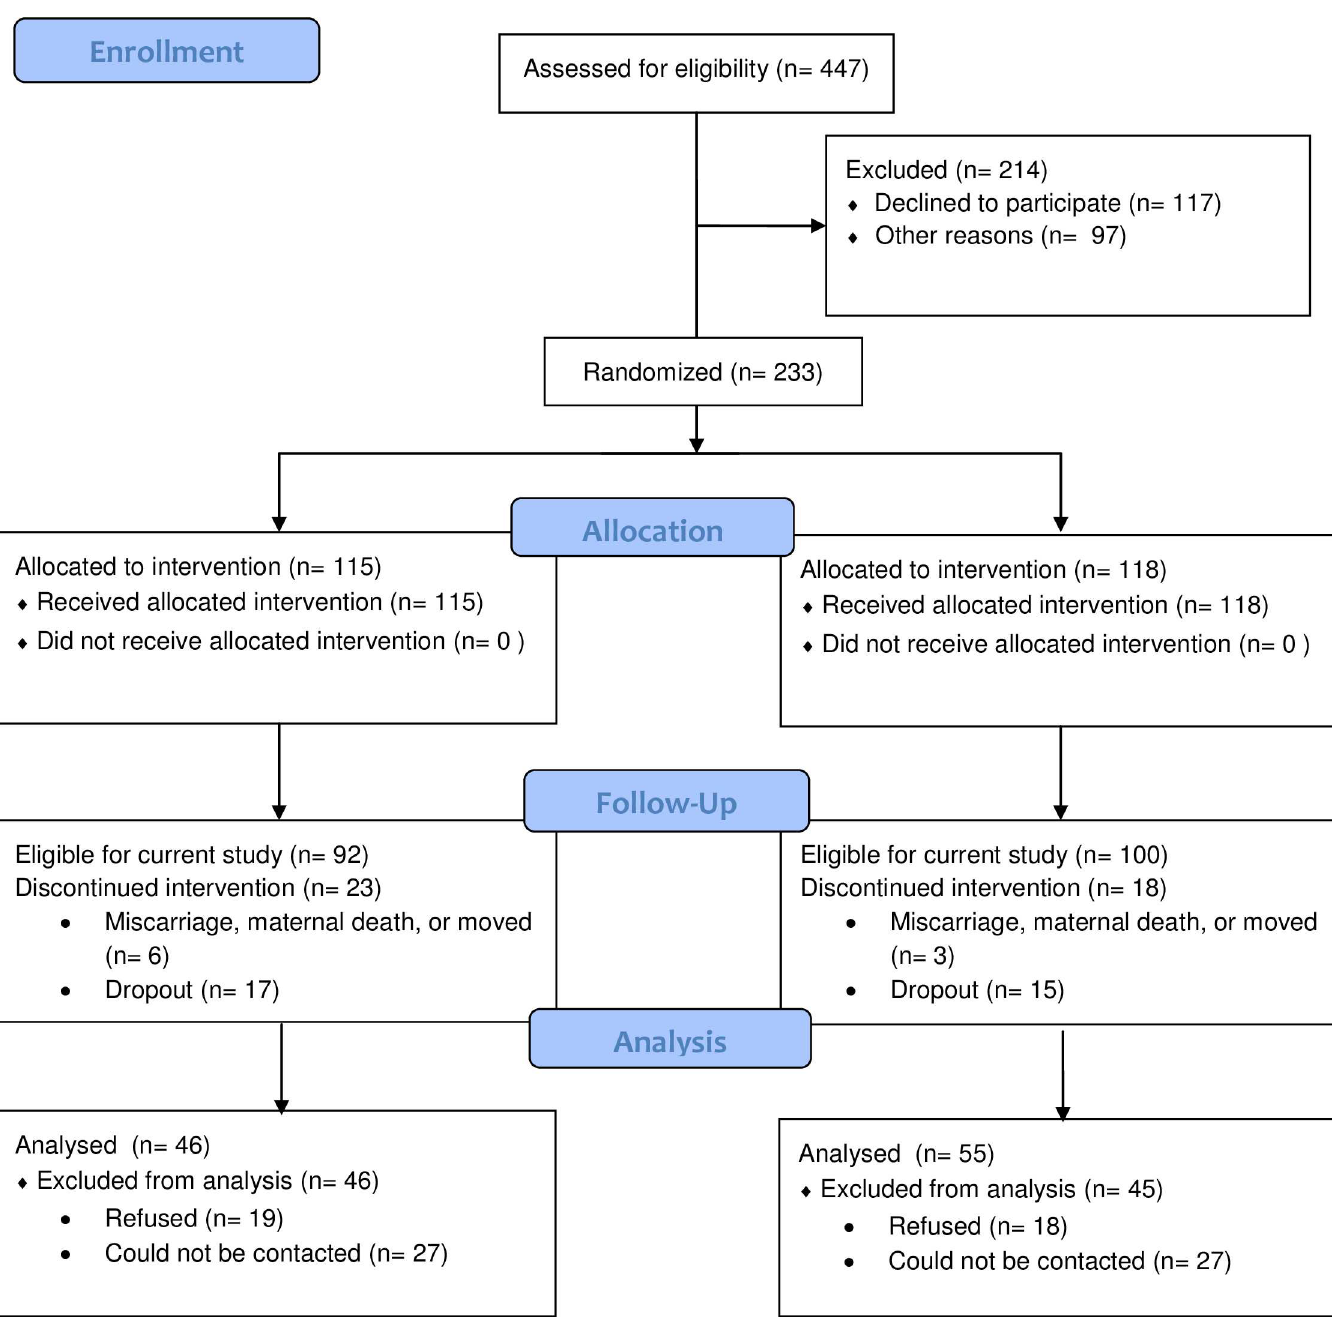
on 96% of the baseline characteristics (46/48) using two-tailed tests with a 10% cut-off for signifi- cance. Significant differences on 2 (4%) measures indicated that mothers in the sub-study were more open (as per the Ten Item Personality Index (TIPI) [69]), and more likely to have their activity impaired by illness. Importantly, there is no selection into the sub-study based on treat- ment status as 46% of the treatment group participated in the sub-study and 54% of the control